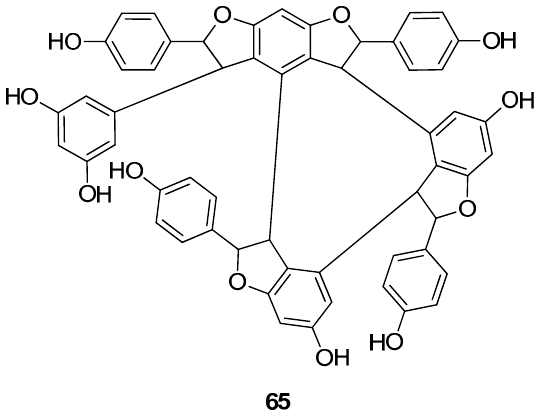
Figure 6. Stilbenoid tetramers isolated from Cyperaceae species .